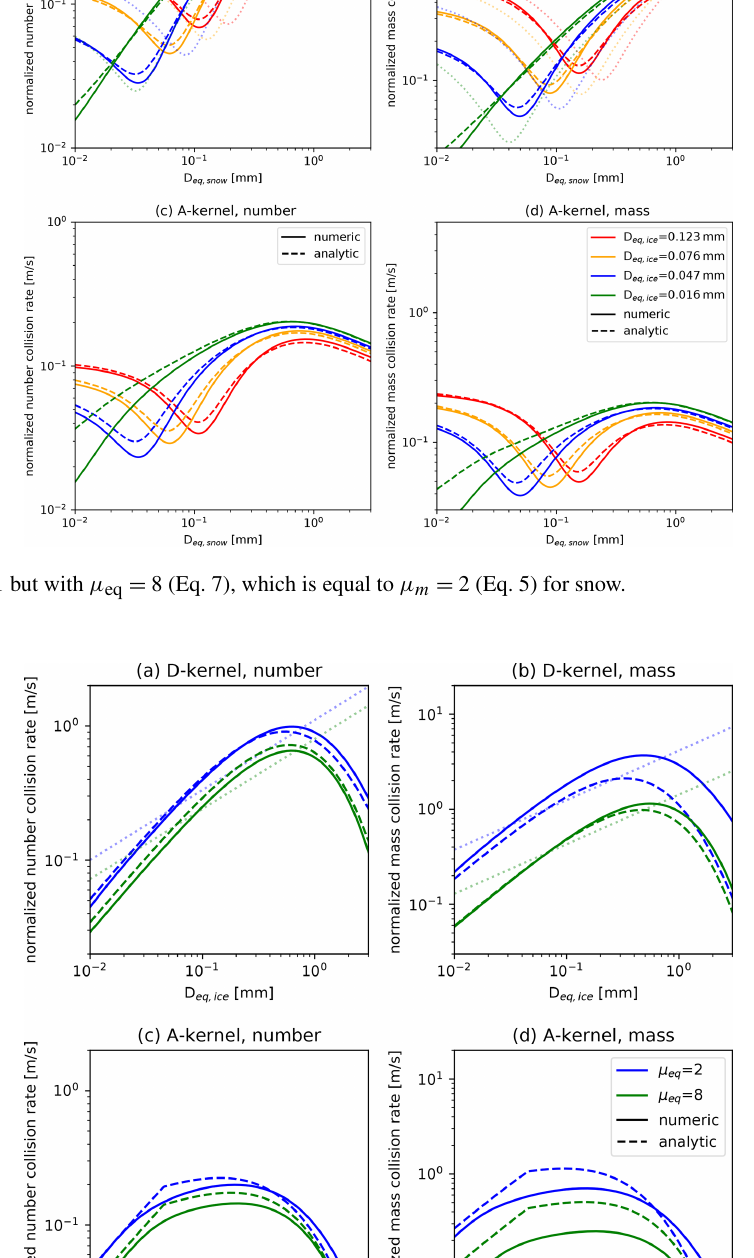
Atmos. Chem. Phys., 21, 17133–17166, 2021